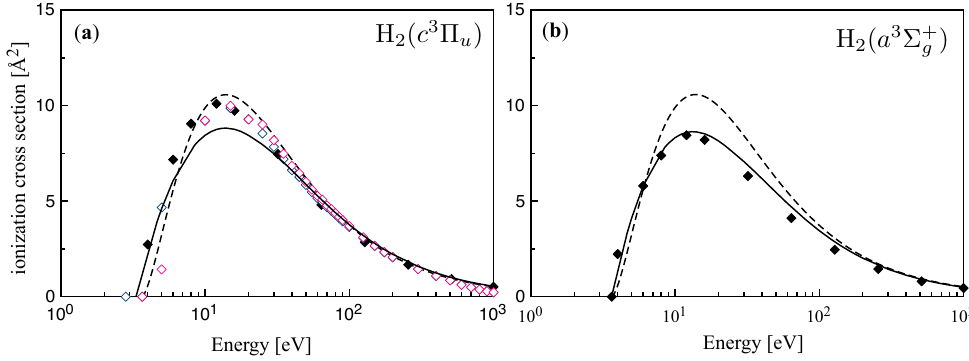
Figure 3. Total ionization cross section of H 2 ( a ) c 3 Π u metastable and ( b ) a 3 Σ + g states. (solid line) BEB model; (dashed line) classical Gryzinski approach [14]; (close diamonds) MCCC method [24,40]; CSP-ic method [36] models A (blue open diamonds) and B (red open